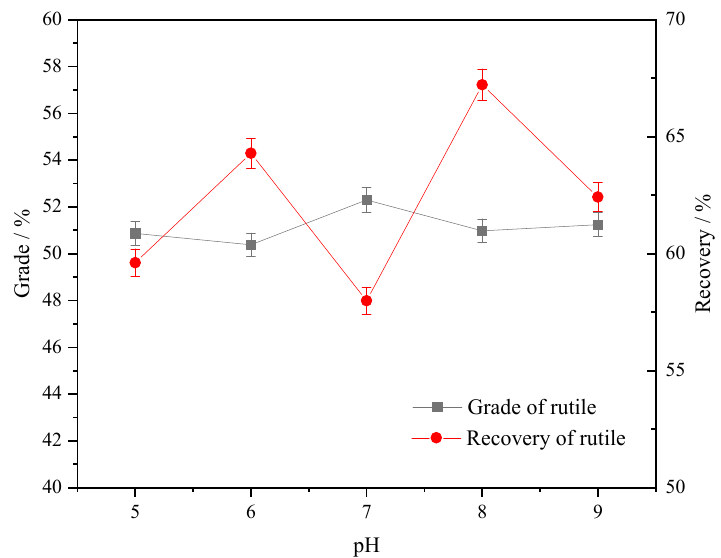
Figure 8. Effect of concentration on Pb 2+ activation of rutile and garnet (pH = 7, concentration of BHA and SSF = 40 mg/L).